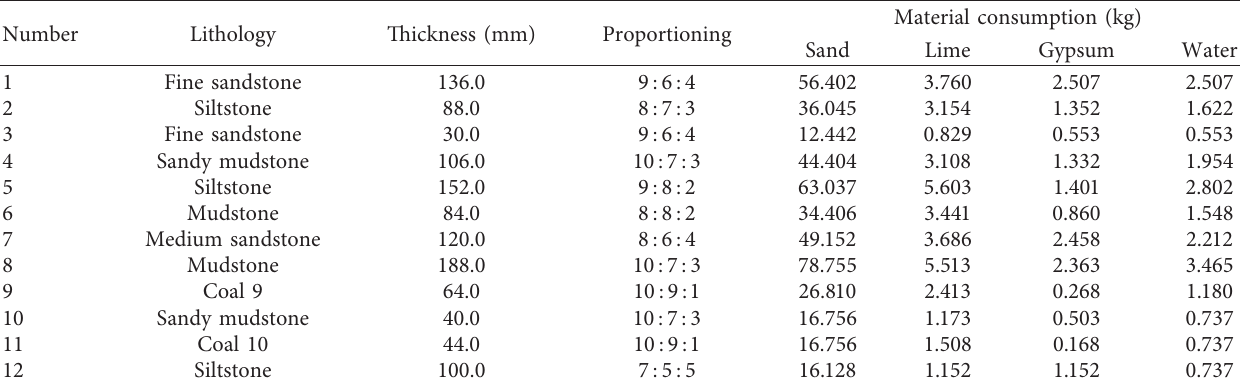
Table 3: Similar simulation strata distribution and material mixture